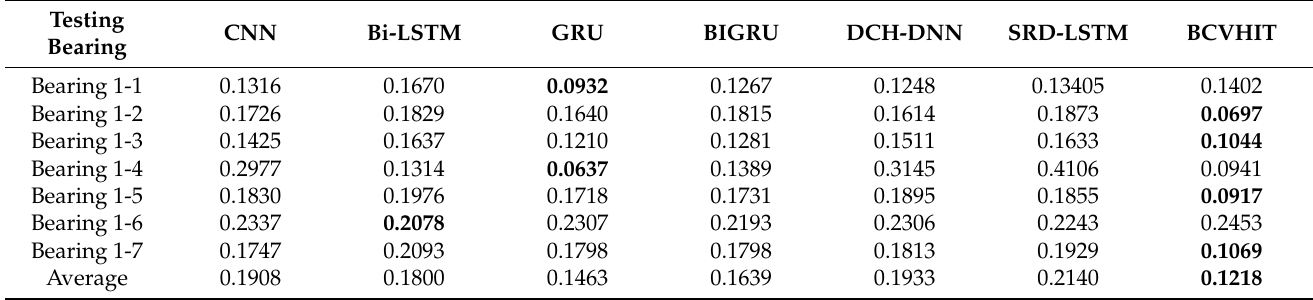
Table 8. Statistical results of different RUL prediction methods in Test